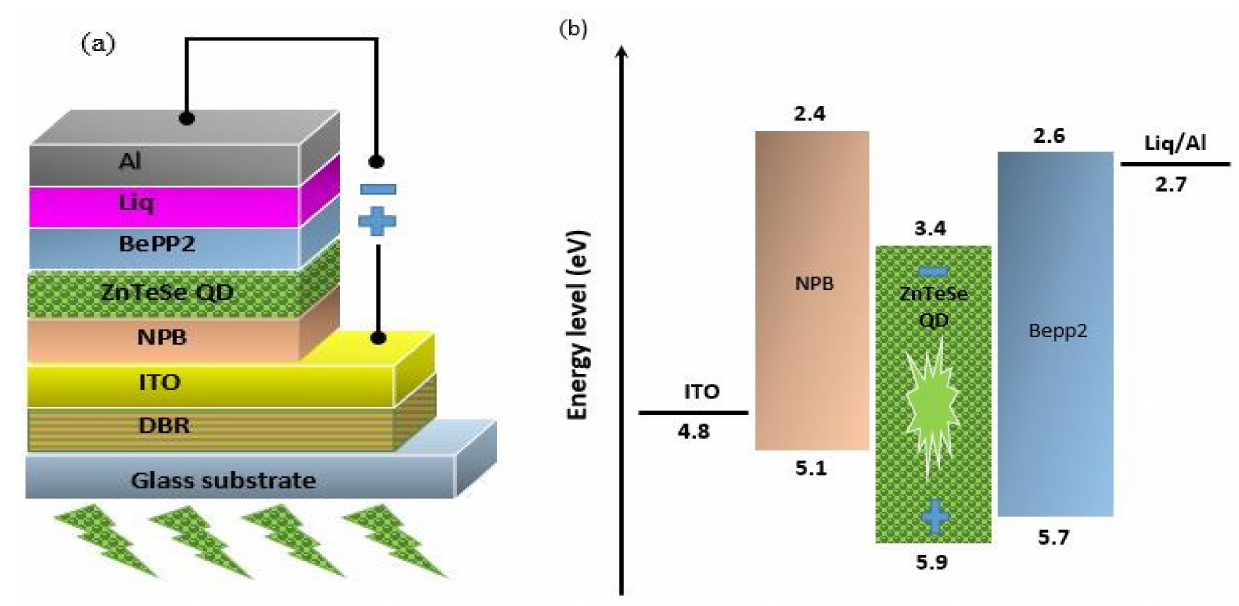
Figure 1. ( a ) Schematic structure of device, ( b ) energy level